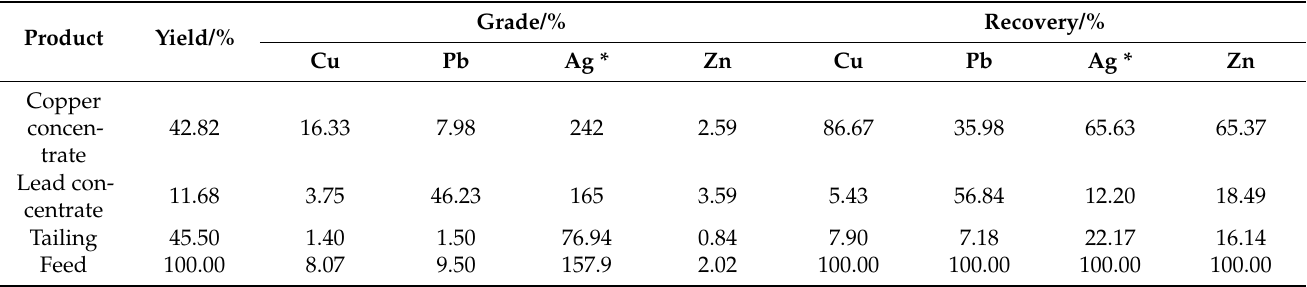
Table 3. The results of closed-circuit flotation test (* Unit: